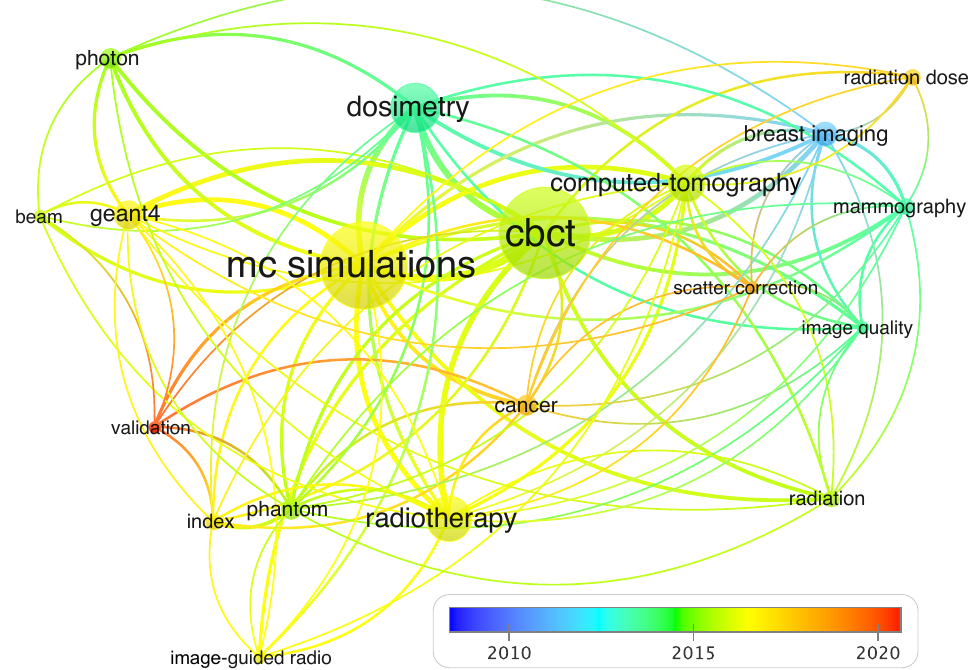
Figure 3. Co-occurrence network of keywords. The thicker line indicates a strong association between those keywords, while thinner lines depict weak